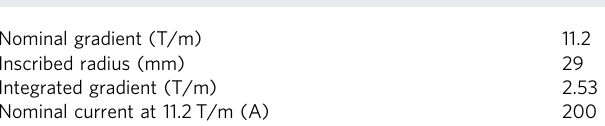
Table 2 Quadrupole magnet speci fi cation.